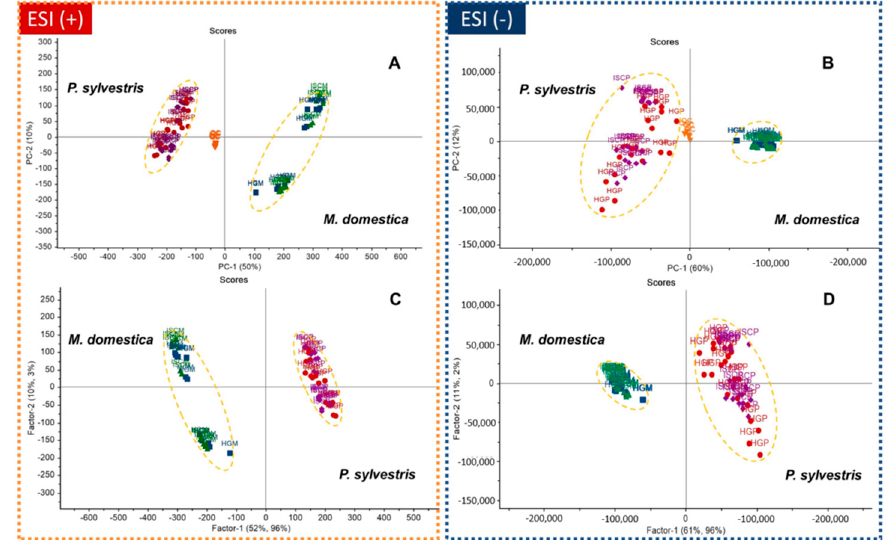
Figure 3. PCA (figures A and B ) and PLS-DA (figures C and D ) score plots from data of V. album fermented aqueous extracts analyzed by LC-ESI(±)-HRMS. Abbreviations: QC: pooled quality control samples, ISCM: M. domestica /APVAE, HGM: M. domestica /VAE, ISCP: P. sylvestris /APVAE; HGP: P. sylvestris